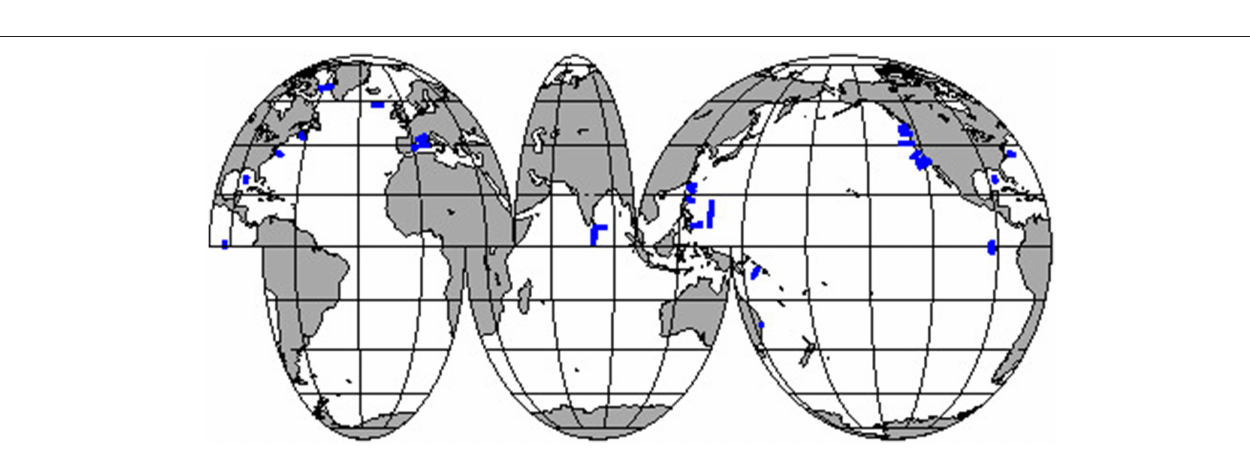
FIGURE 4 | Sustained observations of boundary currents of duration from at least one to over a dozen years. Mean sections of absolute geostrophic velocity are a unique product of underwater gliders, calculated by combining geostrophic shear with directly measured depth-average velocity. These sections at the locations in this figure are shown in Figures 5 , 6